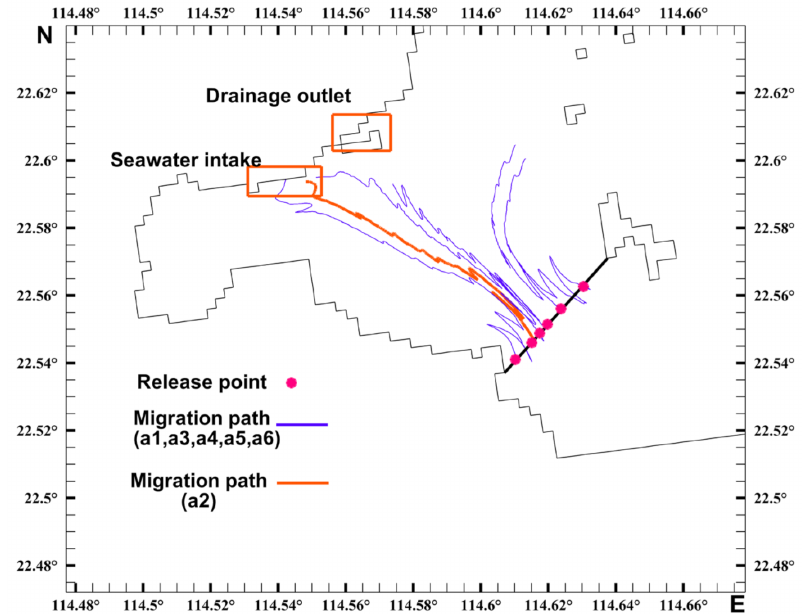
Figure 2. Lagrangian particle-release locations and migration paths (14 h daytime cases).